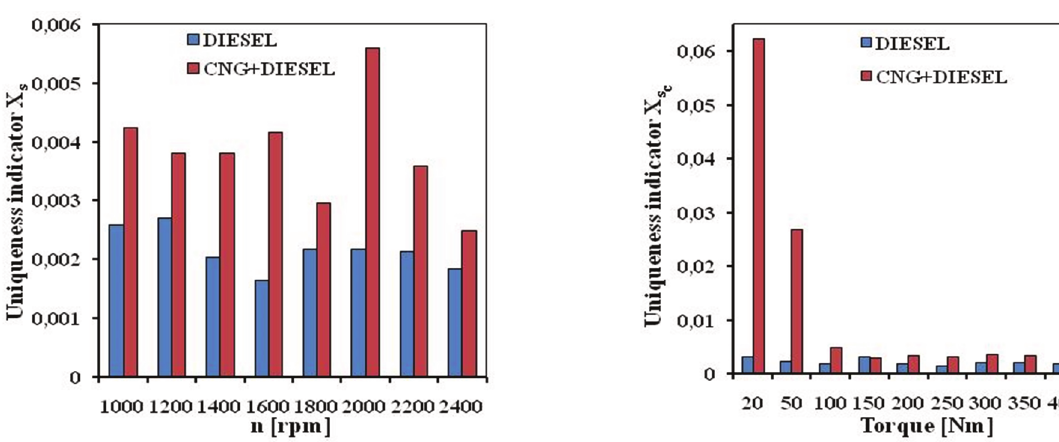
Fig. 12. Comparison of the value of the uniqueness indicator for the indi- Fig. 15. Comparison of the value of the uniqueness indicator for the partial cator diagram of the Perkins 1104D-E44TA engine operating according to indicator diagram for the Perkins 1104D-E44TA engine, operating external speed characteristics, in dual-fuel operation powered by CNG + Diesel and by diesel fuel only